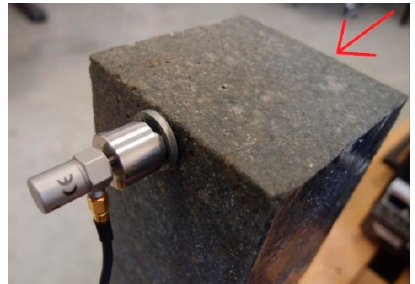
Figure 9. Location of the vibration acceleration sensor indicating the direction of stroke.